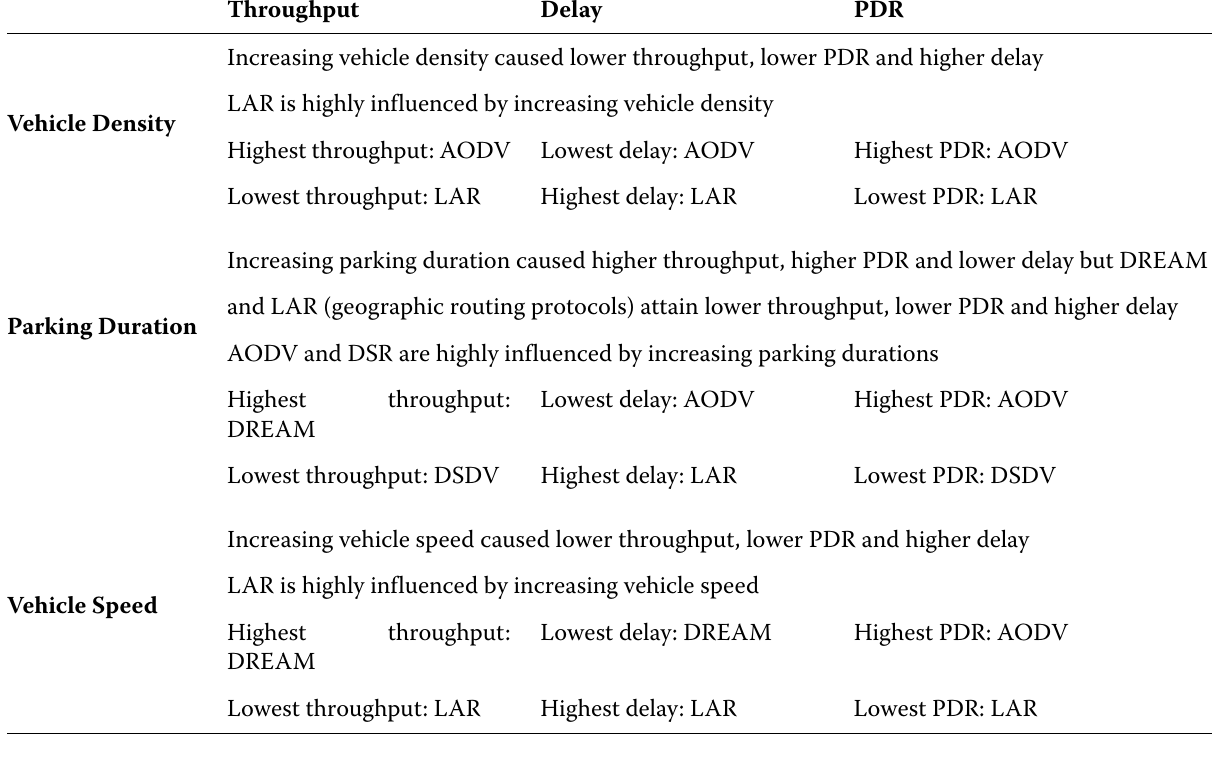
Table 3 Summary of results under various vehicle density, parking duration and vehicle speed Throughput